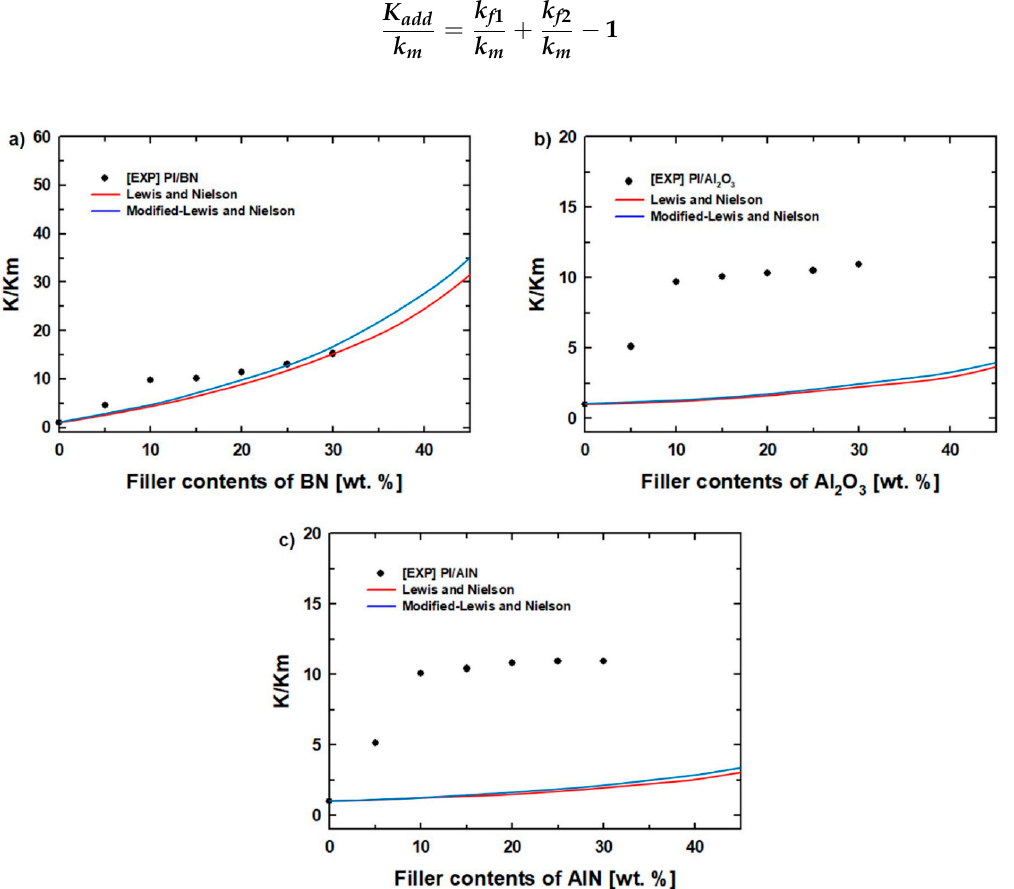
Figure 4. Experimental and theoretical thermal conductivity obtained using the regular and modified Lewis–Nielsen models for the ( a ) PI/BN; ( b ) PI/Al 2 O 3 ; and ( c ) PI/AlN composite films.